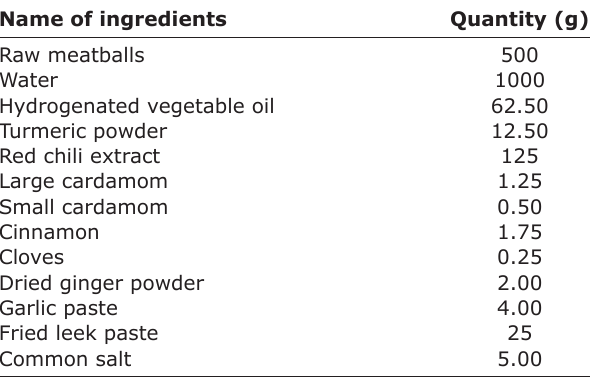
Table-1: Standardized recipe for Rista . Name of ingredients Quantity (g)